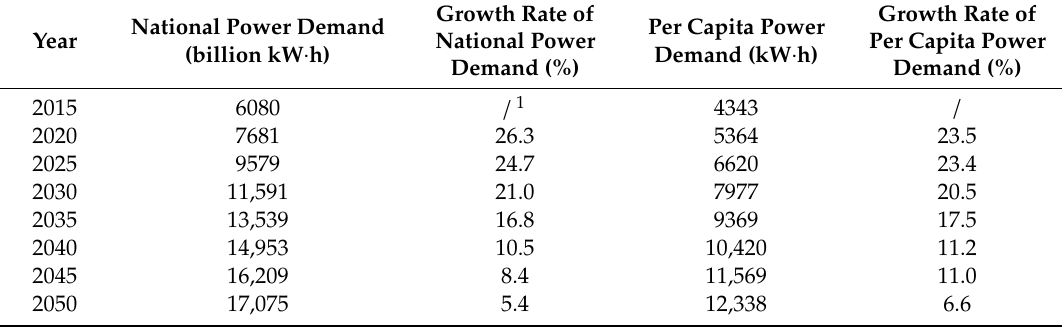
Table 2. Power demand of